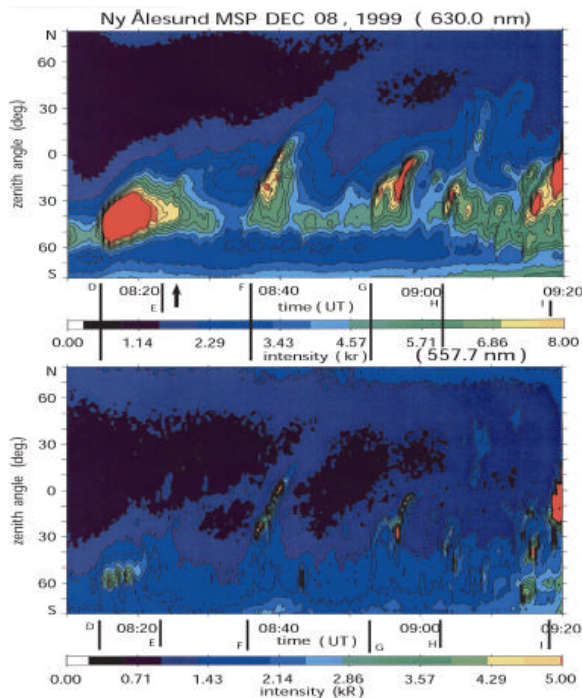
Figure 6 Fig. 6. MSP observations from Ny ˚Alesund at the wavelength channels 630.0 and 557.7nm are shown in the upper and lower panels, respectively. Color-coded line of sight intensities versus zenith angle are plotted for the interval 08:10–09:20 UT. Same format as in Fig.